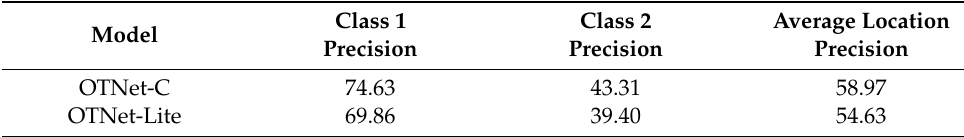
Table 5. The classification results of the